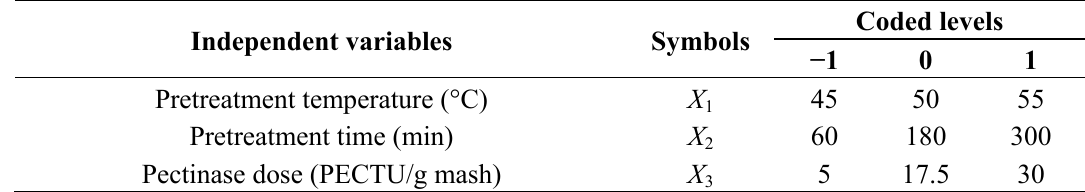
Table 1. The levels of the variables used in the Box-Behnken